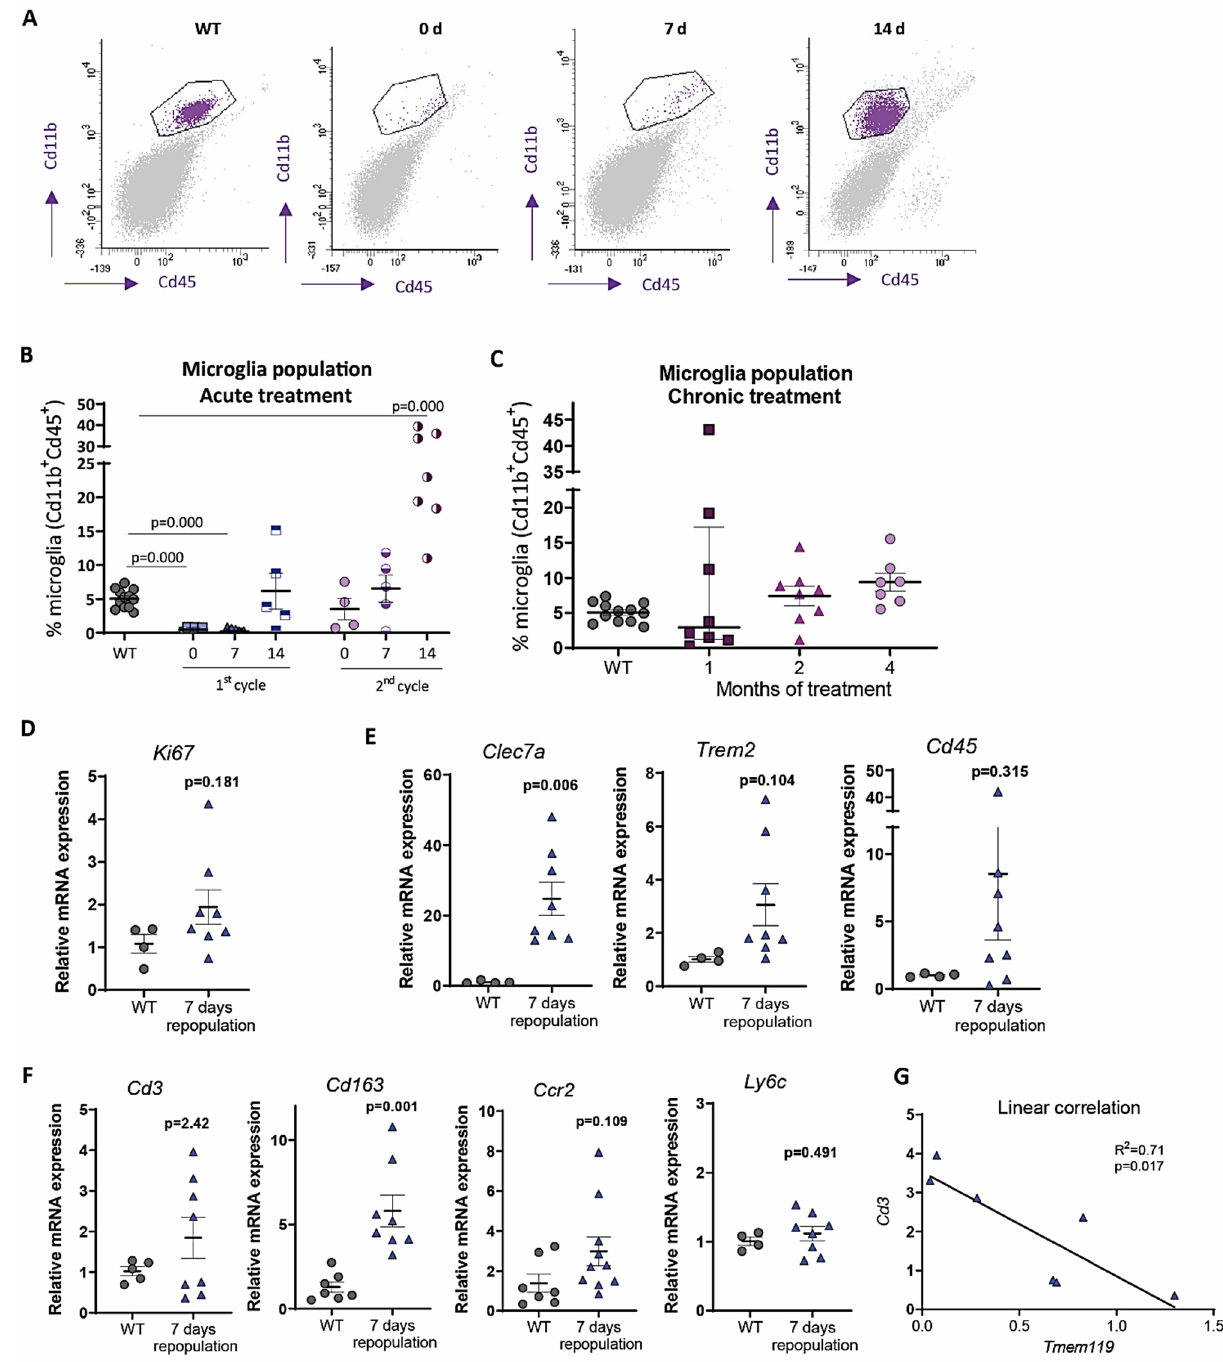
Figure 1. Microglial depletion is followed by a rapid repopulation, mediated by microglial activation, in 2-month-old Cx3cr1 CreER /Csf1r flx/flx mice. ( A ). Representative flow cytometry images for the analysis of microglial cells (Cd45+Cd11b+) in WT and Cx3cr1 CreER /Csf1r flx/flx mice subjected to acute tamoxifen treatment (7 days) and sacrificed 0, 7, or 14 days after the end of the treatment. ( B ). Quantification of microglial population after tamoxifen acute treatment, by flow cytometry, in cortical regions. The 1st cycle: 7 days tamoxifen; 2nd cycle: 7 days of tamoxifen administration after 14 days of the end of the first cycle. Mice were sacrificed 0, 7, or 14 days after the end of the corresponding cycle. ( C ). Microglial population, quantified by flow cytometry, in WT and Cx3cr1 CreER /Csf1r flx/flx mice subjected to oral tamoxifen administration for 1, 2 or 4 months. Animals were sacrificed at the end of the treatment. ( D – F ). Quantification, by qPCR, of mRNA expression of the proliferation marker Ki67 , normalized by Gapdh (D); microglial activation markers Clec7a , Trem2 , Cd45 , normalized by Tmem119 ( E ); and immune infiltration markers Cd3 , Cd163 , Ccr2 and Ly6c , normalized by Gapdh ( F ); in the hippocampus of WT and Cx3cr1 CreER /Csf1r flx/flx mice subjected to acute tamoxifen treatment and sacrificed 7 days after. ( G ). Correlation between Tmem119 (microglial homeostatic marker) and Cd3 (lymphocytic marker) mRNA expression, quantified by qPCR